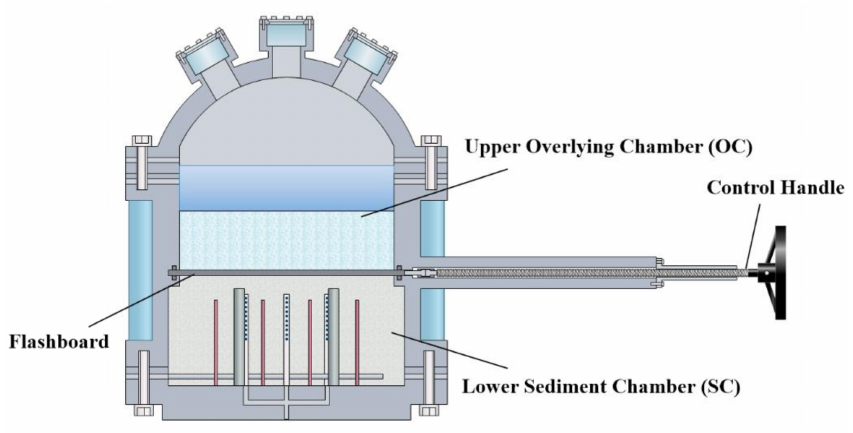
Figure 2. Schematic diagram of the DLCS sectional